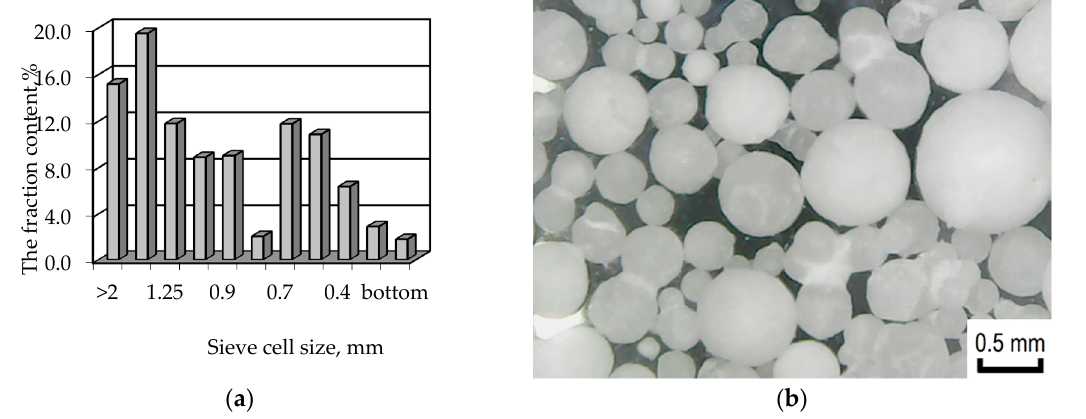
Figure 5. Particle size distribution ( a ) and photomicrographs ( b ) of polypropylene brand Moplen HF501N.